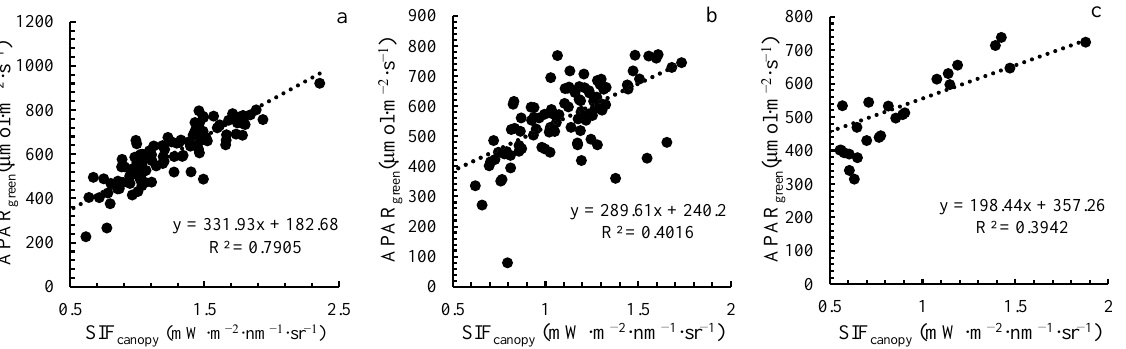
Figure 9. The relationship between SIF canopy and APAR green at different stages of onset of wheat stripe rust. ( a ) Mild disease stage ( n = 104), ( b ) intermediate disease stage ( n = 99), and ( c ) severe disease stage ( n = 29).